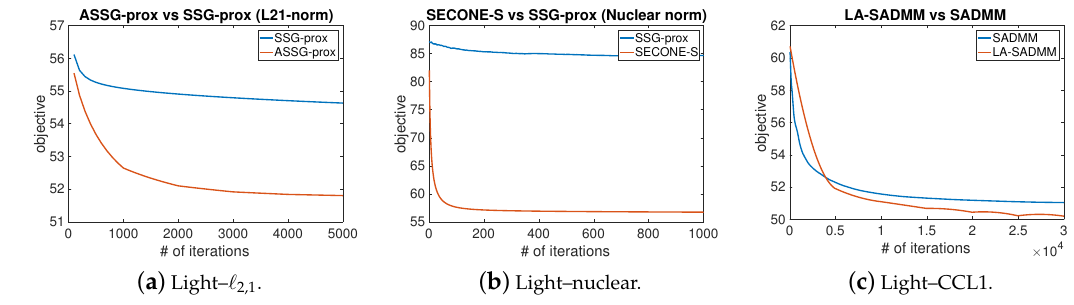
Figure 4. Optimization